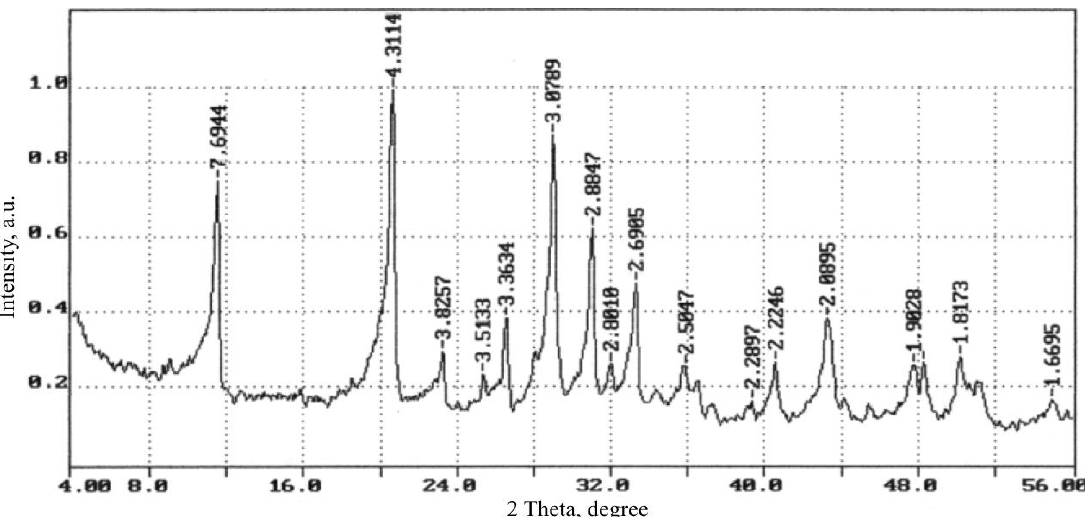
Figure 10. XRD pattern of the hardened GCB-FA. Identical for both types of fiber.